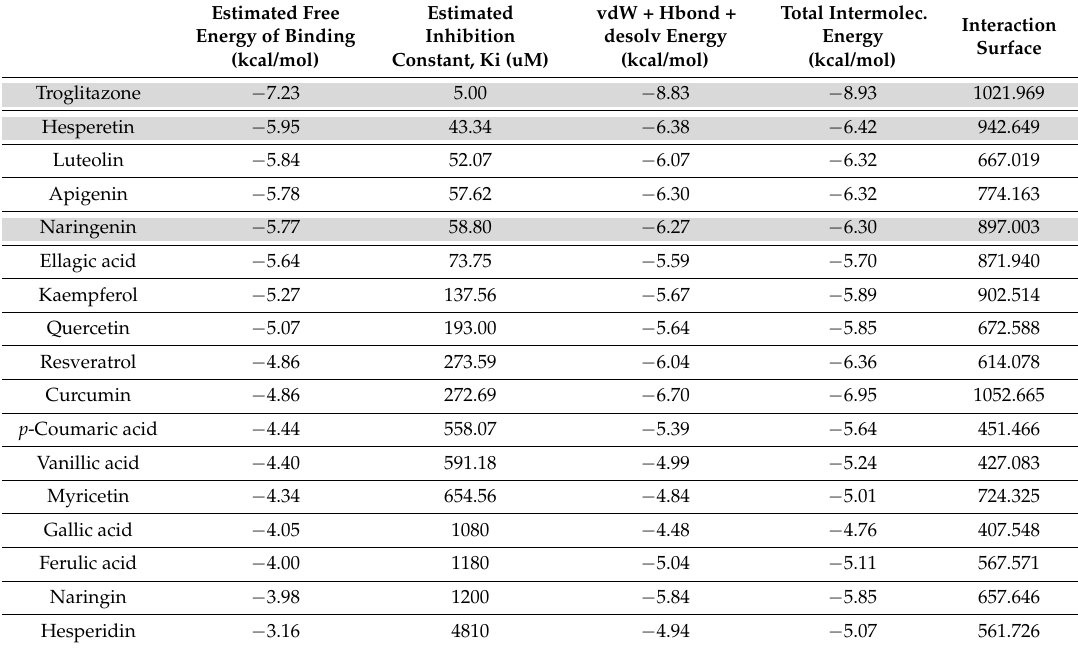
Table 1. Free energy values for the ligand-protein interactions predicted by DockingServer. Troglitazone and aglycones from Naringin and Hesperidin (Naringenin and Hesperetin) are shown, shadowed in grey, for comparative